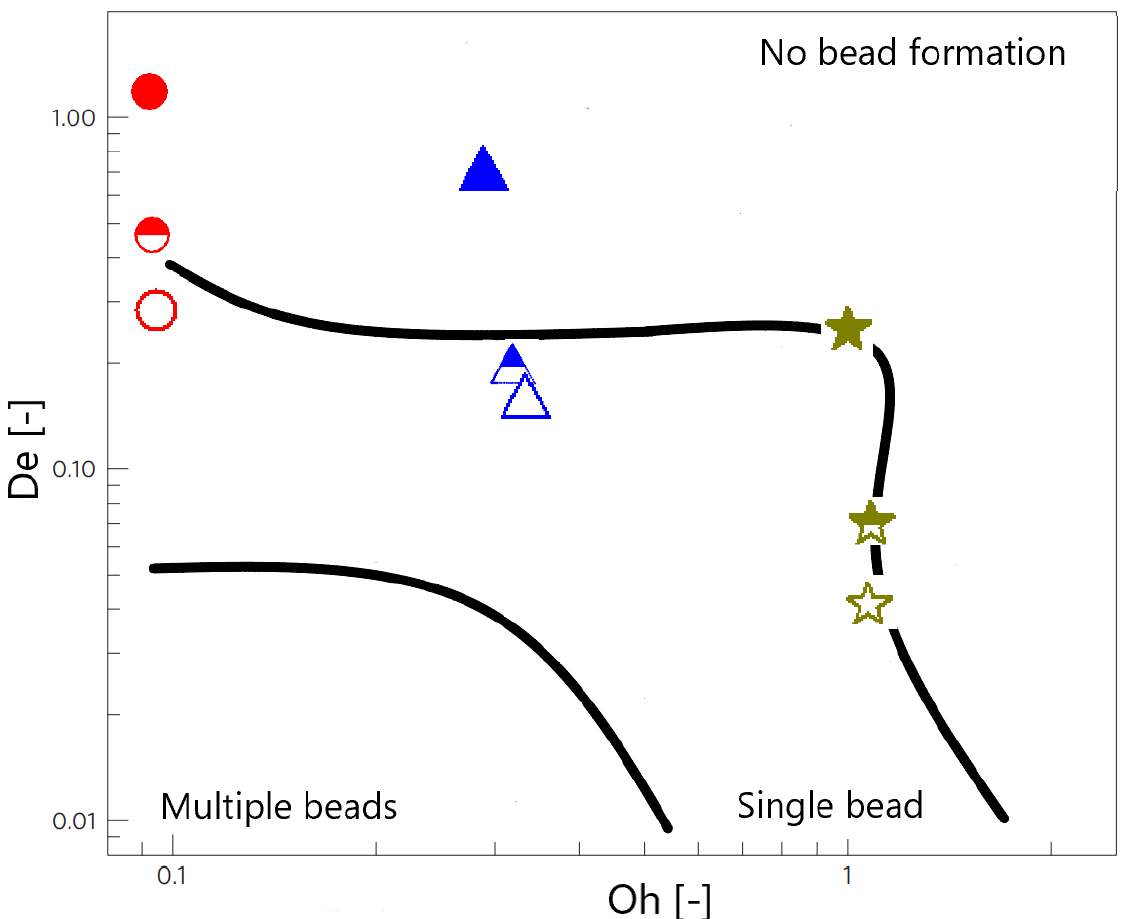
Figure 8. Phase diagram depicting the regions showing different BOAS morphologies in the De and Oh space adapted from [42]. Symbols represent the experimental data corresponding to this work, following the same color and symbol scheme as in Figure 5.